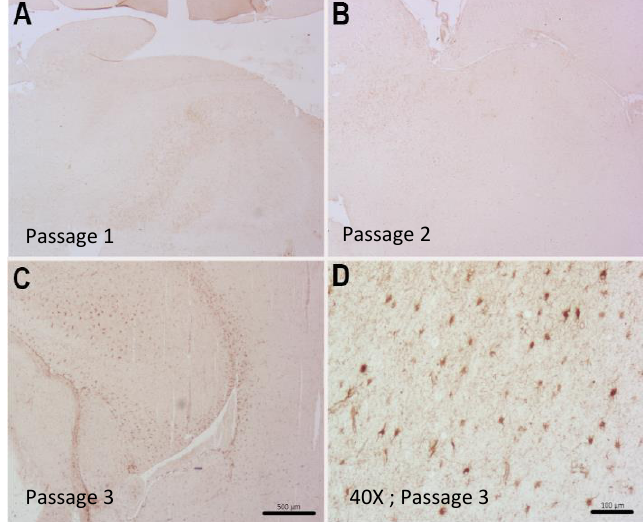
Figure 4. Patient-derived PDX model of case 2409 showing diffuse STEM 121 staining of human-derived cells in passages 1 and 2 ( A , D ), and a more localized staining with some invasion in passage 3 ( G ). An adjacent section of human nuclei staining showed the same pattern of diffuse staining in passages 1 and 2 ( B , E ) and a localized staining with some invading cells evident in passage 3 ( H ). Increased cellularity and infiltration of proliferating tumor cells were apparent in H&E stained sections Insets ( C , F , I ) show individual cellular staining. Scale bar = 500 µ m. Inset scale bar = 100 µ m).